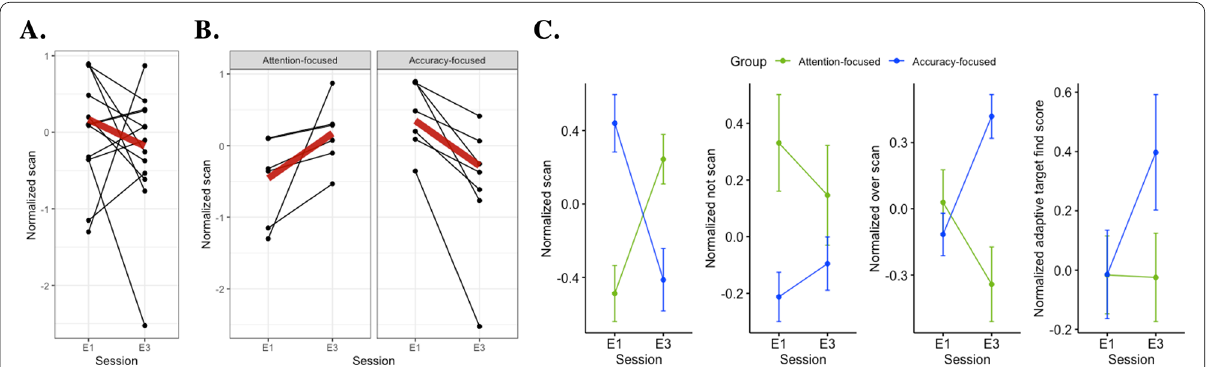
Fig. 4 Overall and subject-specific changes in behavioral measures across training sessions. A Changes in scan measures from easy session 1 (E1) to easy session 3 (E3). B Six individuals displayed an increasing change in scan measure from E1 to E3, while seven displayed a decreasing behavior. C Mean changes in scan, not scan, over scan, and adaptive target find measures. Black dots represent mean scan measures across subareas per subject and session. Colored dots and associated error bars represent mean and standard error of mean across subareas and subject